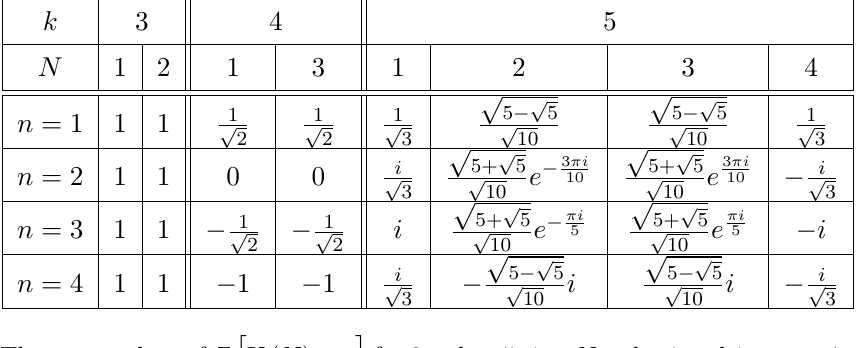
Table 6 . The exact values of Z Only the values that are related to the duality are included here. The values of Z be obtained by taking the complex conjugate to Z